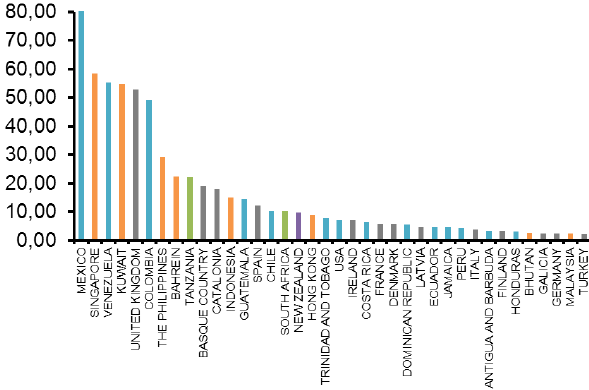
Figure 3. Average number of tweets posted per day by NMS (from beginning to 30 August 2014).